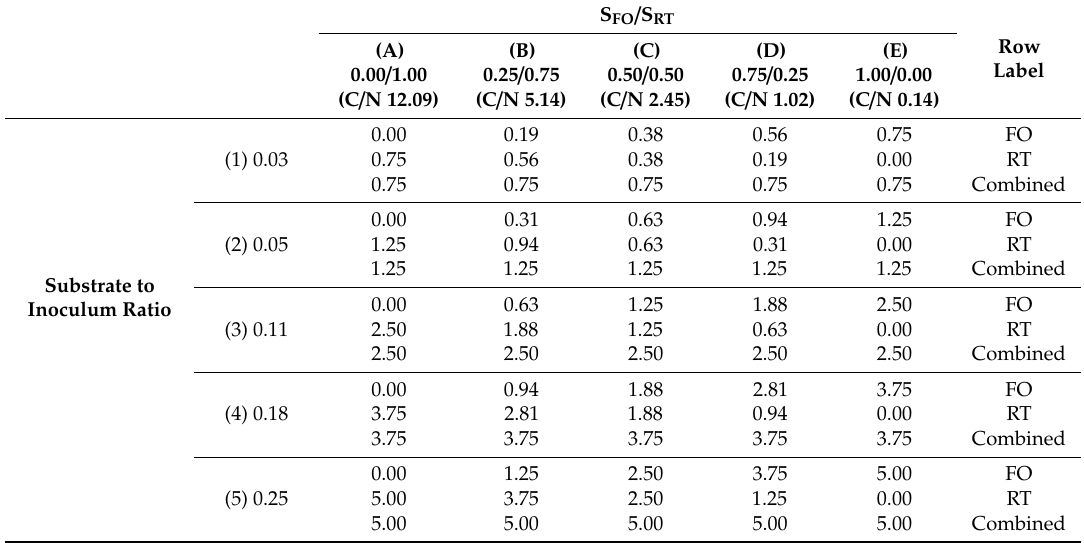
Table 2. Masses of fish o ff al, river tamarind and their combined masses placed in the bioreactor.